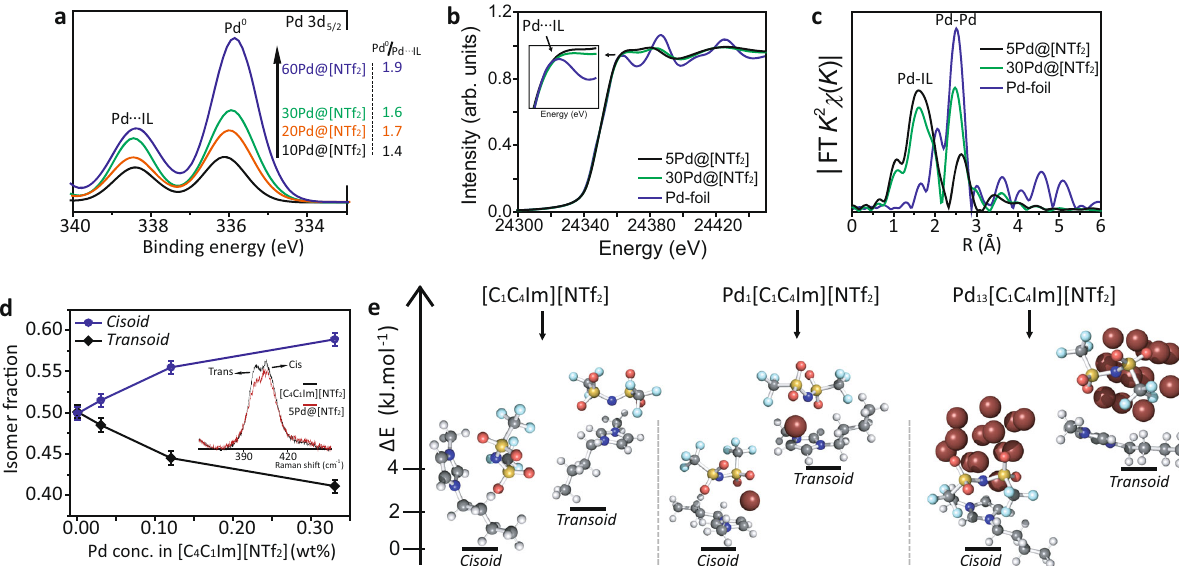
Fig. 2 Electronic environment of Pd and ILs system. a X-ray photoelectron spectroscopy (XPS) spectra for the Pd 3d 5/2 of 10Pd@[NTf 2 ], 20Pd@[NTf 2 ], 30Pd@[NTf 2 ] and 60Pd@[NTf 2 ] (no Pd signal was observed at lower Pd concentration — Supplementary Fig. 22a). b , c Pd K -edge X-ray absorption near- edge structure (XANES) and Fourier transform of k 2 -weighted extended X-ray absorption fi ne structure (EXAFS) spectra, respectively, of 5Pd@[NTf 2 ], 30Pd@[NTf 2 ] and Pd foil (PdO spectrum can be found in Supplementary Fig. 26). Pd-IL: coordination of Pd-C from [C 4 C 1 Im] cation and/or Pd-O/N from [NTf 2 ] anion. d Relative cis -/ trans - conformational isomer (conformer) fractions as a function of Pd concentration obtained from Raman